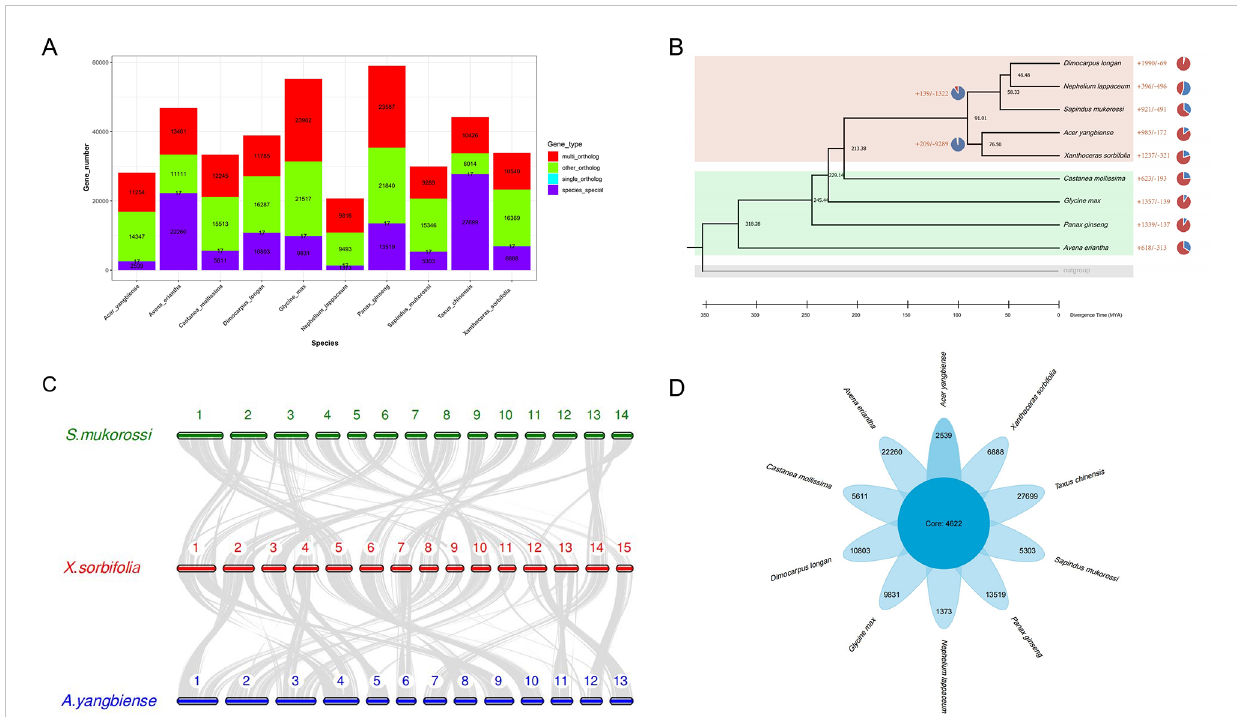
FIGURE 2 Comparative analysis yellowhorn and nine other representative angiosperms. (A) Gene family clusters. Multi_ortholog: This family exists in all species, and the number of members in at least one species is greater than or equal to two; single_ortholog: a single copy orthologous gene family, which exists in all species and has 1 member in all species; other_ortholog: The family exists in at least two species and does not exist in at least one species; species_special: the unique gene family of each species. (B) Maximum-likelihood phylogeny of yellowhorn and nine other representative angiosperms. (C) Collinear analysis by comparing the yellowhorn ( X .sorbifolia, XsoG11) genome with Acer yangbiense ( A. yangbiense ) and Sapindus mukorossi genomes ( S. mukorossi ). (D) The comparative genomic analysis shows the number of the core and species speci fi c gene